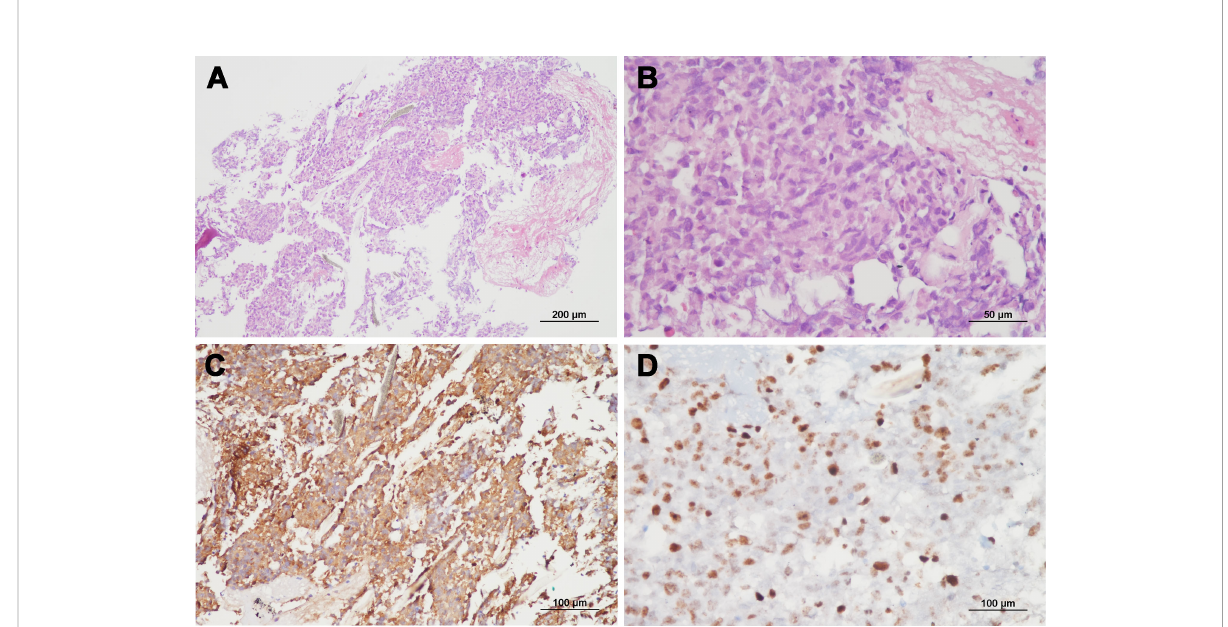
FIGURE 4 Representative microphotos of a vertebral lesion with GFAP immunopositivity and high Ki-67 proliferation index, consistent with a diagnosis of metastatic glioblastoma. ( A, B : hematoxylin and eosin staining, original magni fi cation ×100 & ×400, C : GFAP immunohistochemistry, original